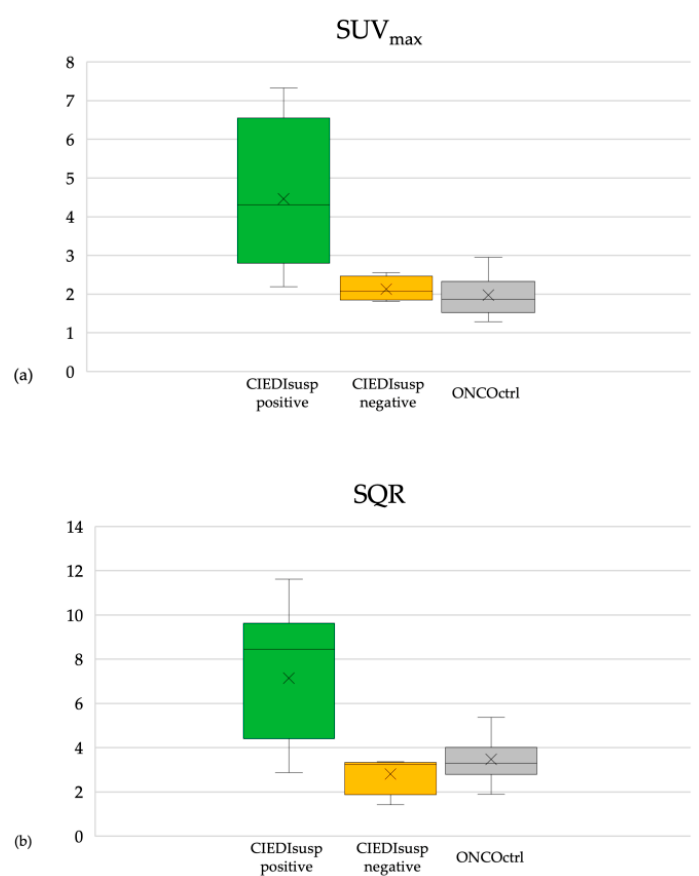
Figure 3. ( a ) SUV max distribution in CIEDIsusp patients positive at 18 F-FDG PET / CT, CIEDIsusp patients negative at 18 F-FDG PET / CT and oncological surveillance without clinical suspicion of CIED infection group (ONCOctrl) patients. ( b ) SQR distribution in CIEDIsusp patients positive at 18 F-FDG PET / CT, CIEDIsusp patients negative at 18 F-FDG PET / CT and ONCOctrl patients. In patients with diagnosis of CIED infection, the mean value of SUV max was 3.91 (range: 1.96–7.33; SD = 1.87). In patients without CIED infection, the mean value of SUV max was 2.14 (range: 1.29–4.96; SD = 0.86). The di ff erence between them was statistically significant ( t = 3.35; 95% CI: 0.68% to 2.85%; p < 0.05) [Figure 4a]. The mean value of SQR was 6.07 (range: 2.88–11.63; SD = 3.17) in patients positive for CIED infection and 3.72 (range: 1.43–9.54; SD = 1.8) in negative ones. The di ff erence was statistically significant ( t = 2.57; 95% CI: 0.40% to 4.29%; p < 0.05) [Figure 4b]. Exploratory SUV max cut-o ff value resulted as 2.56 (area under the curve (AUC) = 0.957; ES = 0.032; 95% CI: 0.395% to 0.519%) while exploratory SQR cut-o ff value resulted as 4.15 (AUC = 0.878; ES = 0.071; 95% CI: 0.239% to